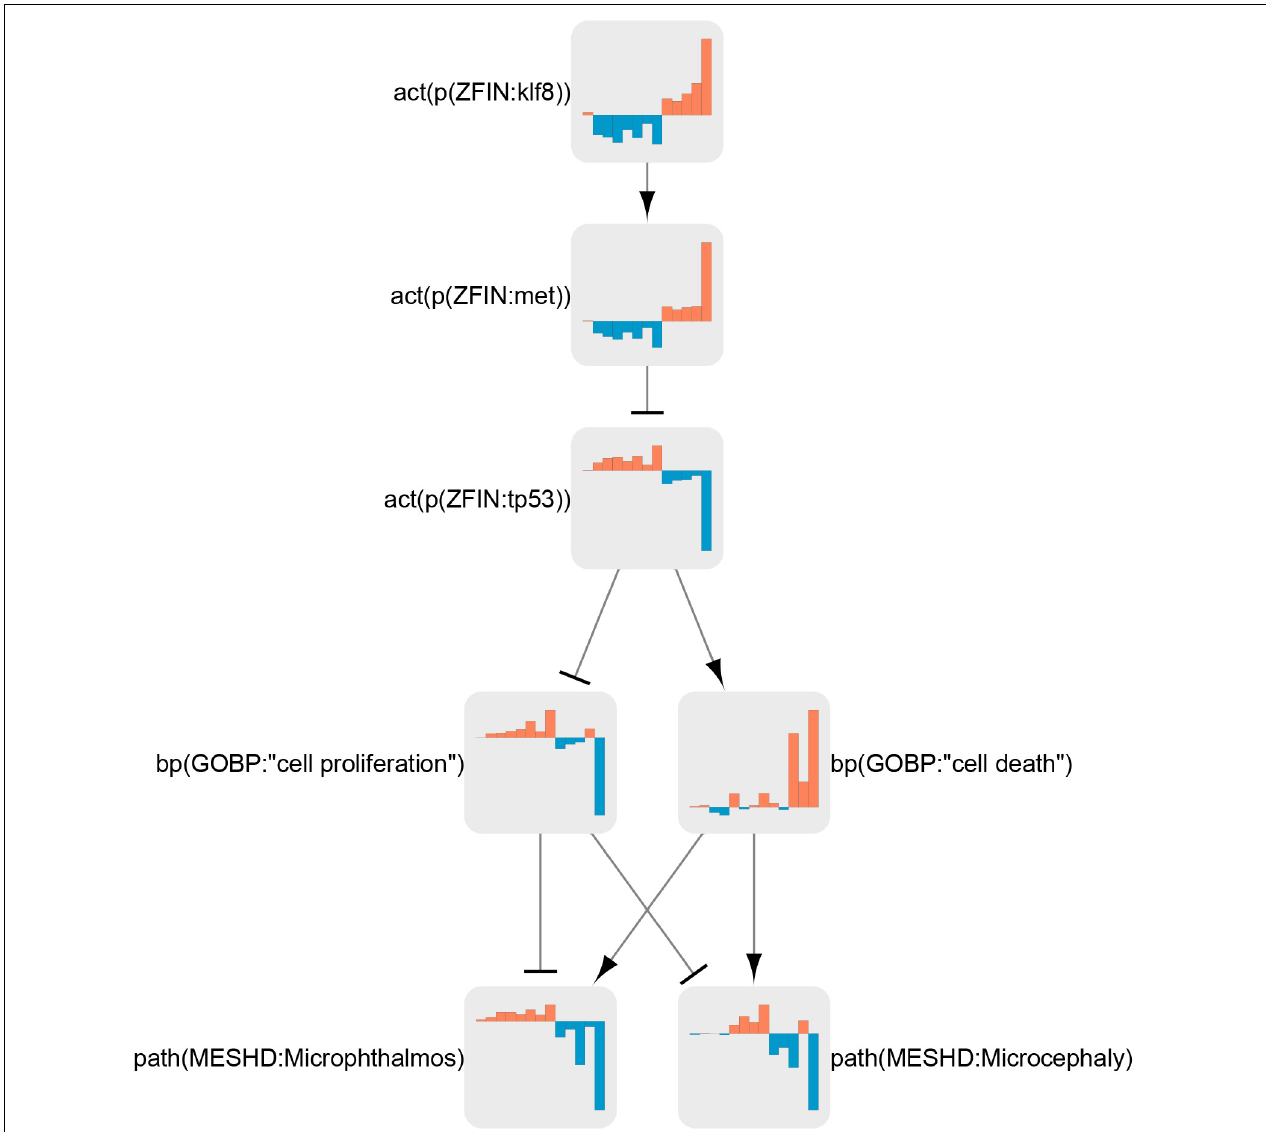
FIGURE 7 | Klf8 regulation in the neurotoxicity network. Node coefficient values (see section “Materials and Methods”) for all treatments are shown as bar graphs. Bars from left to right correspond to neuroactive (ser 25 µ g/L, ser 250 µ g/L, flu 25 µ g/L, flu 250 µ g/L, suvo, imip, 8beta 10 µ M, and 8beta 100) and neurotoxic (domo 3 dpf, domo 7 dpf, Pb 72 hpf, Pb 120 hpf, and rb1) conditions. Orange bars indicate activation, and blue bars indicate